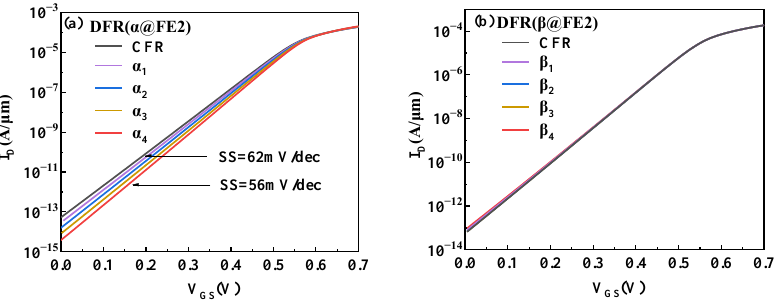
Figure 10. Transfer characteristic curves of the CFR-NCFET and DFR-NCFET with ( a ) variable α in FE2 region, ( b ) variable β in FE2 region.